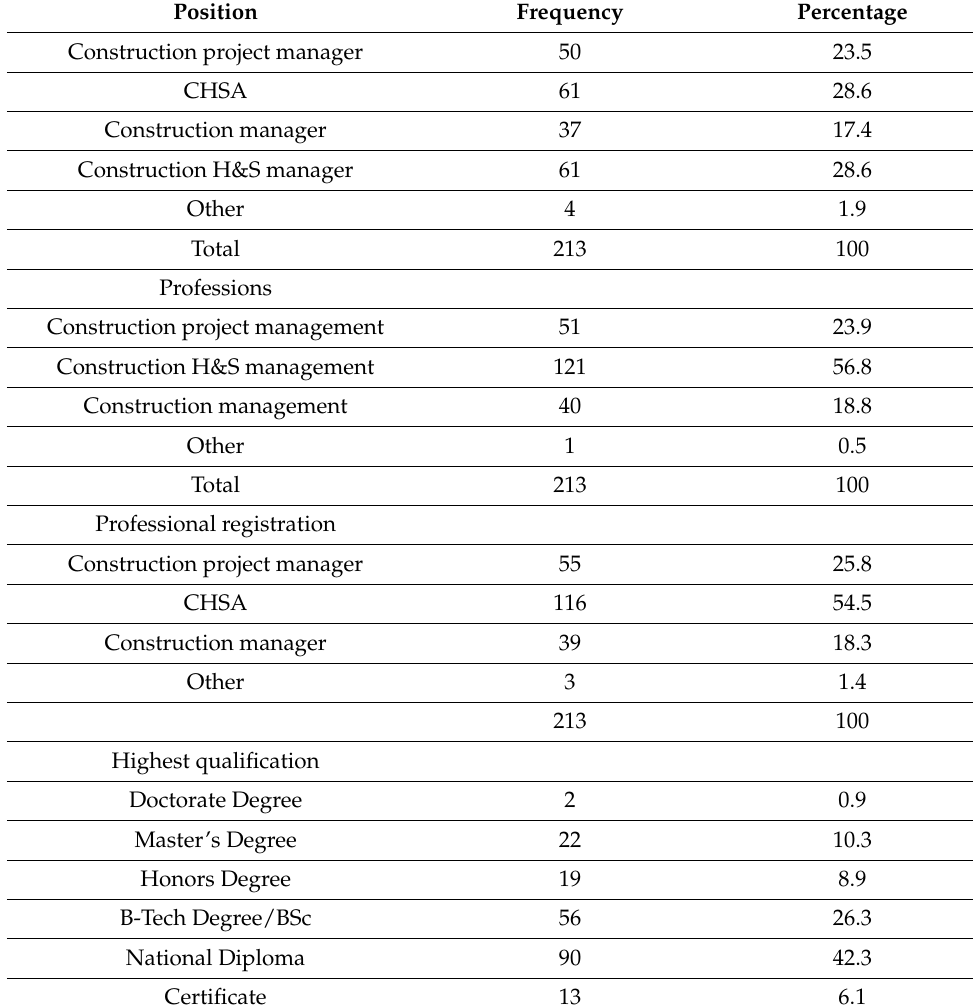
Figure 1. A model for improving CHSA collaboration and influence on H&S performance. Table 3. Respondents’